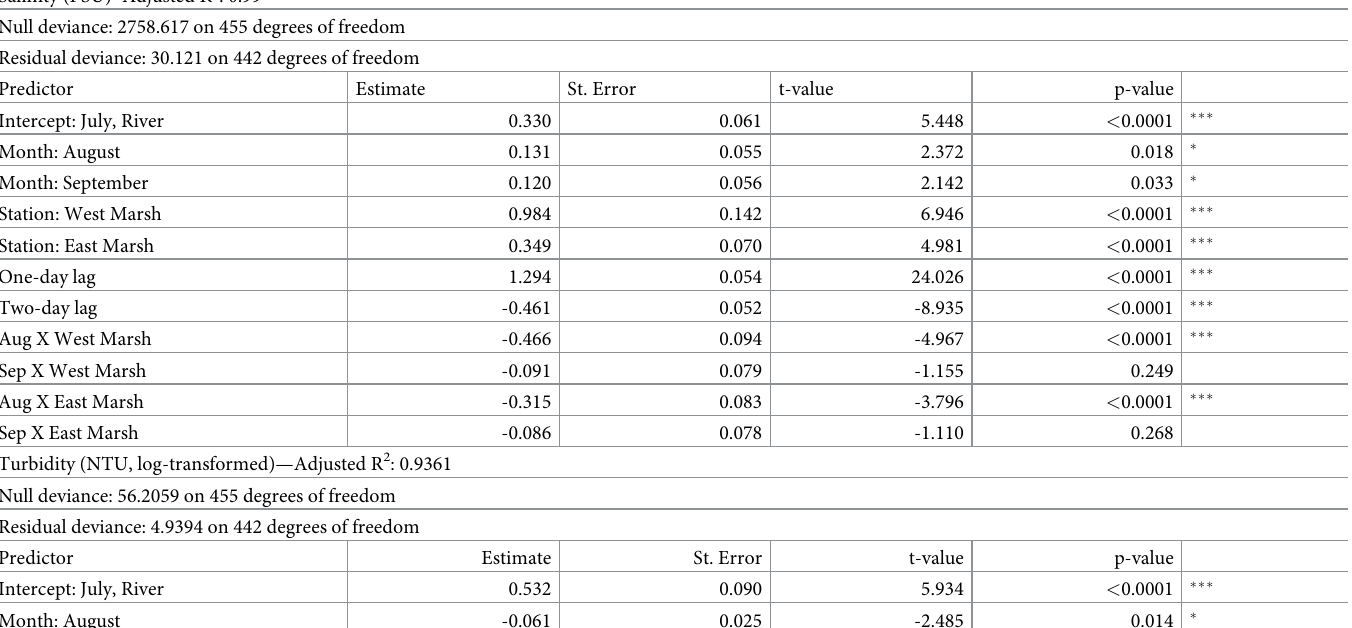
Table 2. Linear model results for water quality and lower trophic data for the action month (August) versus before and after the Flow Action and between regions for 2018. Salinity (PSU)–Adjusted R 2 :